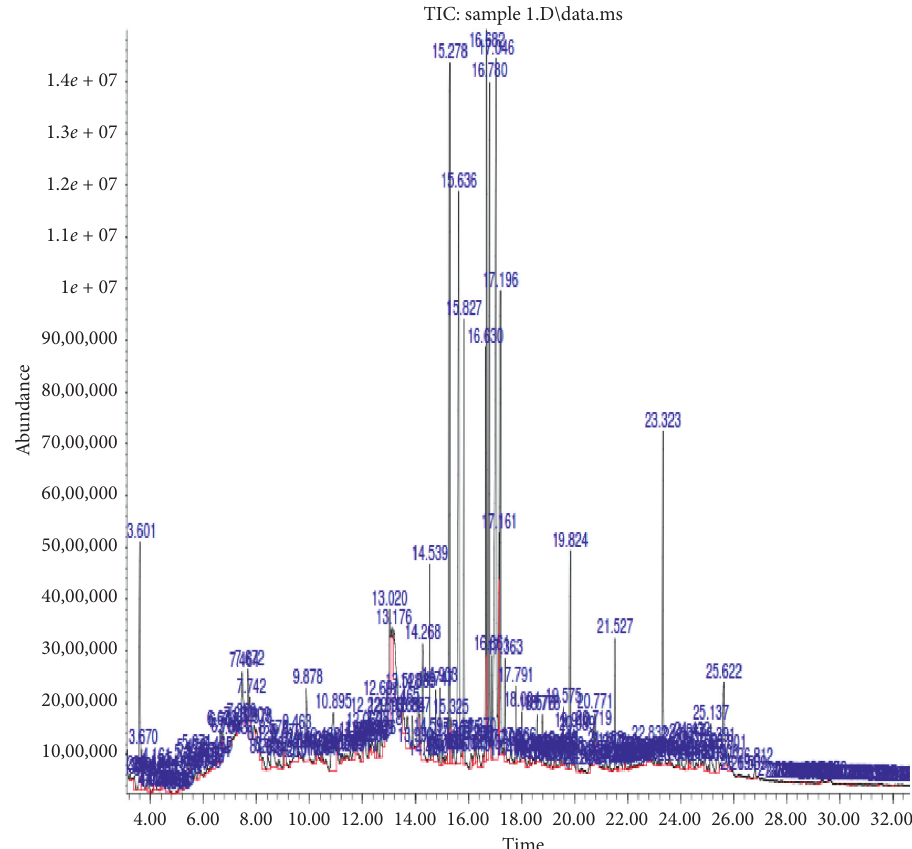
Figure 1: Mass spectrometry of the Clerodendrum volubile ethanol leaf extract ( CVE ) indicating molecular weights of each of the secondary metabolites and their relative